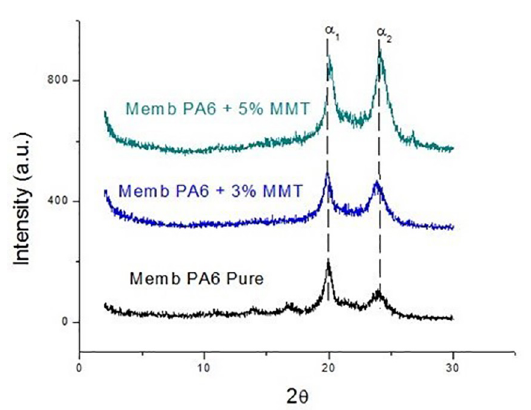
Figure 2. XRD patterns of clay, PA6 and its nanocomposites with different clay content (3 and 5%)